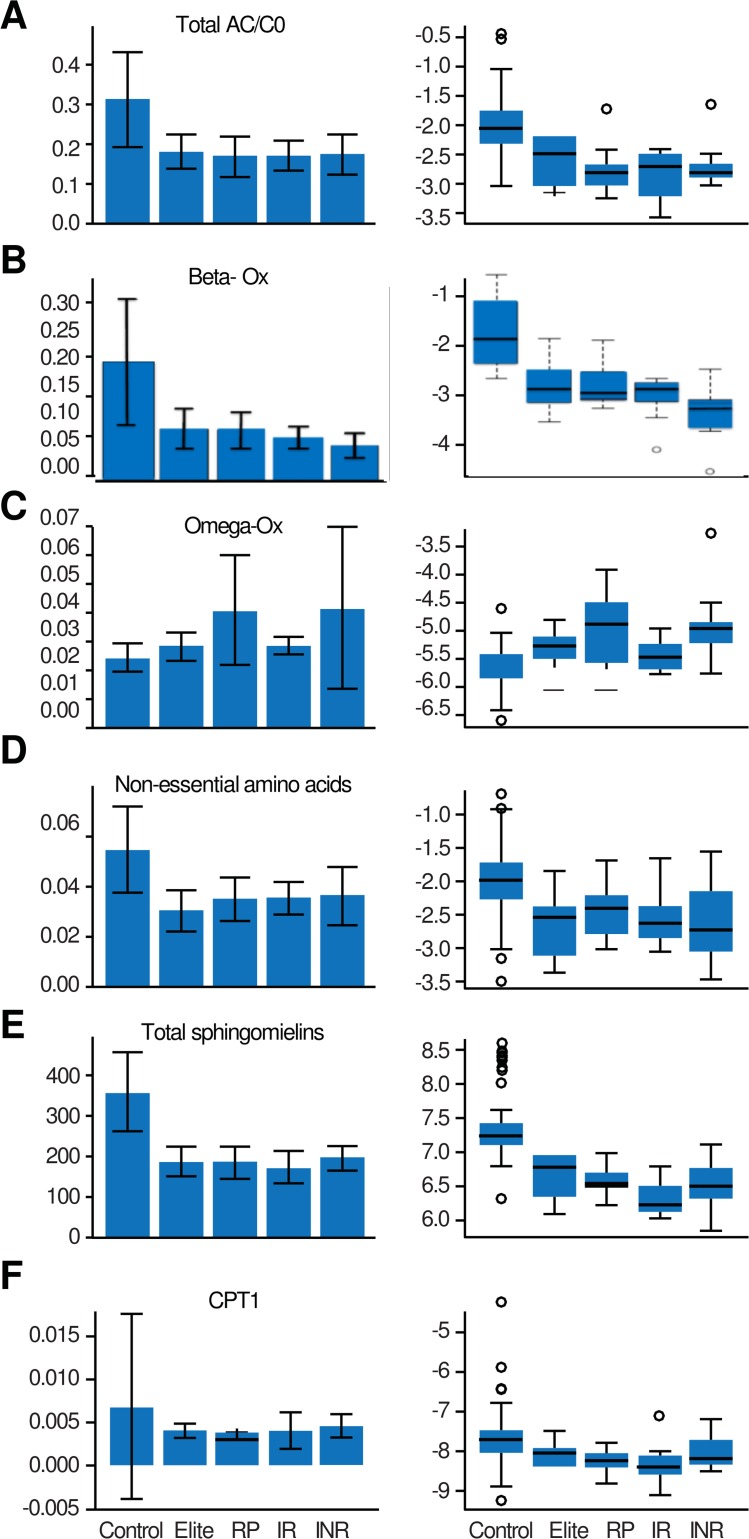
Proportion of Esterified to free Carnitines (Total AC/C0) (A; p = 9.8245E-11 and FDR = 4.1977–10), Beta oxidation (B; p = 1.3529E-13 and FDR = 8.4782E-13) Omega Oxidation (C; p = 6.9445E-11 and FDR = 3.1085E-10), Non-Essential Amino acids other than Glu and Asp (D; p = 1.5306E-47 and FDR = 7.1938E-46), sphingomyelin (E; p = 1.1088E-18 and FDR = 6.74E-19) and uptake of fatty acids to mitochondria (CPT1) (F; p = 0.0016126 and FDR = 0.0026136). Y Axis is depicting micro molar plasma concentrations. Cont = controls; Elite = elite controllers; RP = rapid progressors; IR = immunological responders; INR = immunological non-responders.